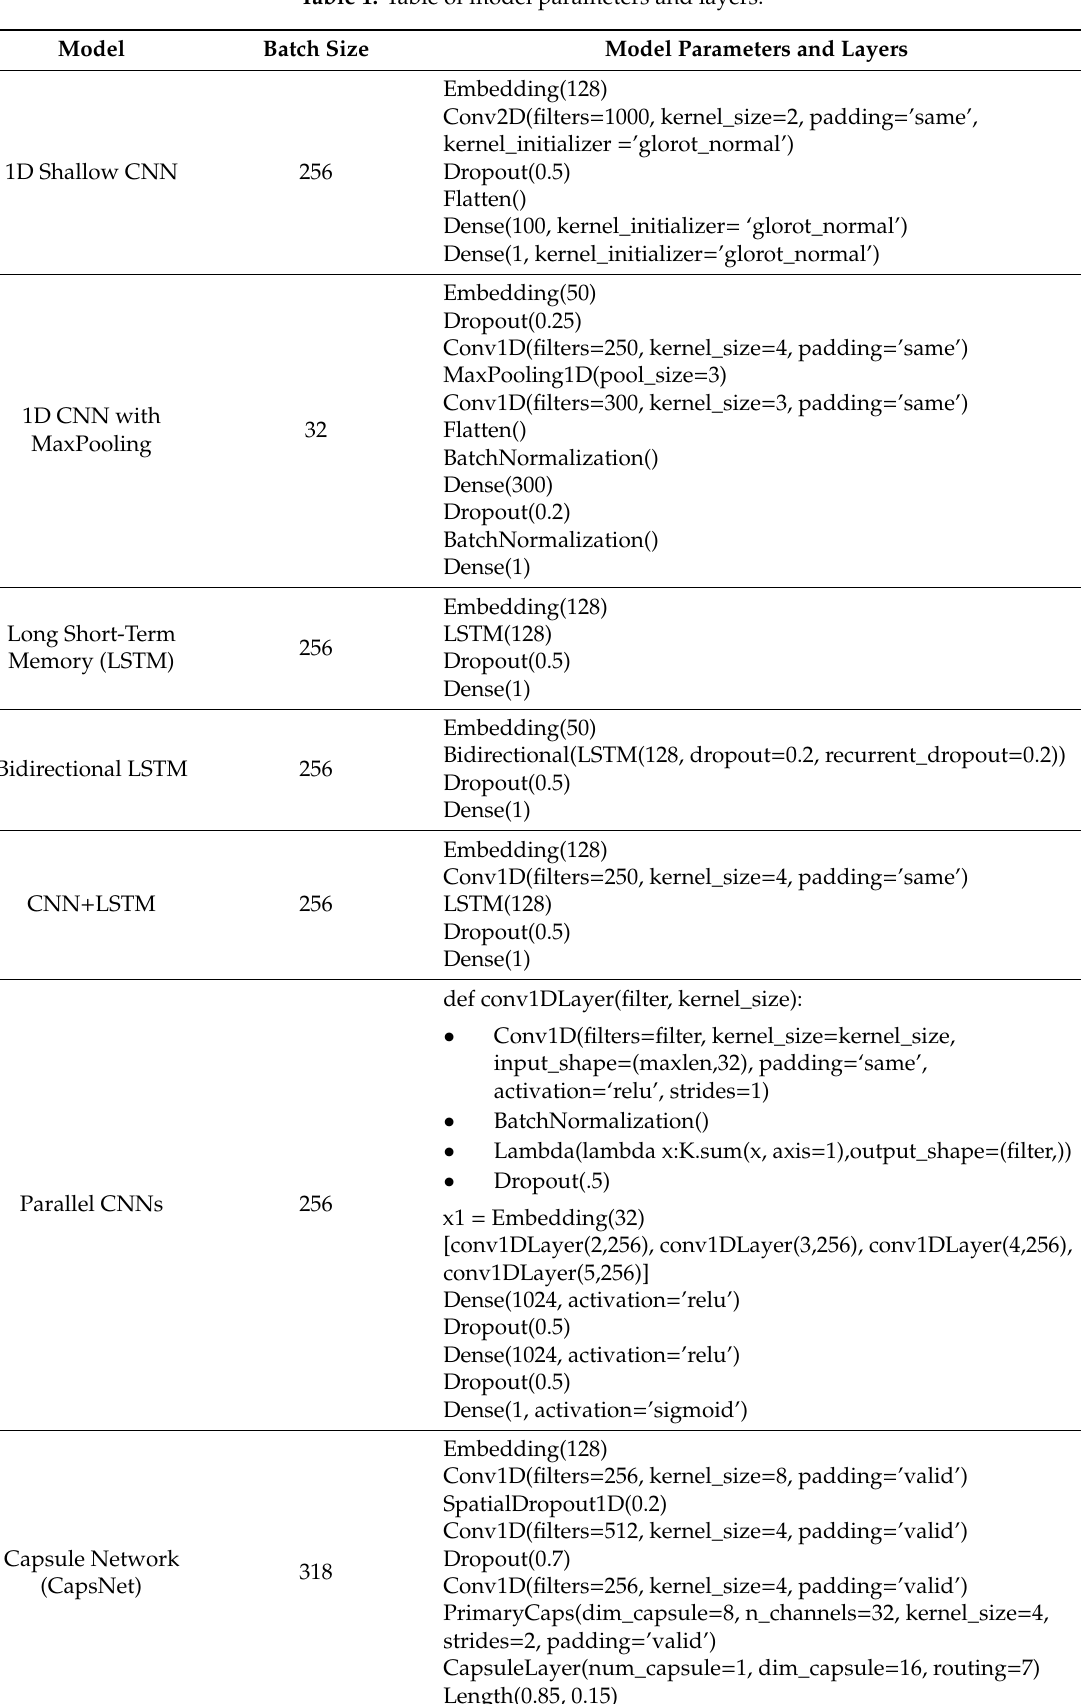
Table 1. Table of model parameters and